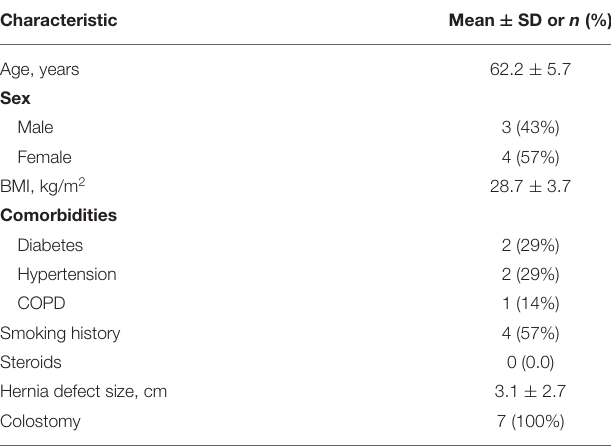
TABLE 1 | Characteristics of the study population.